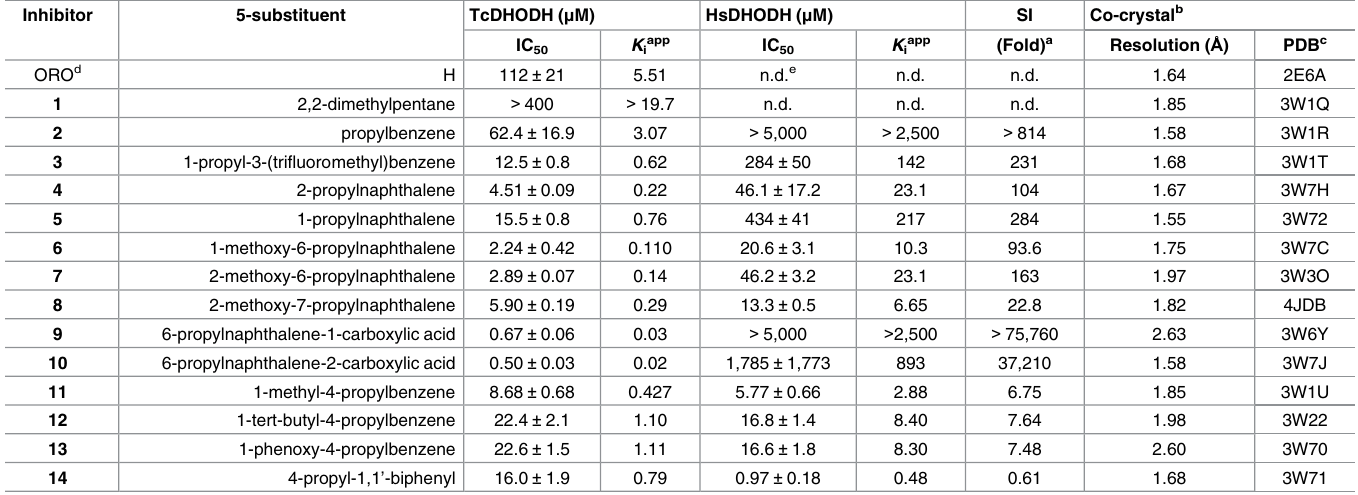
Table 1. 5-substituted orotate derivativesdesigned in this